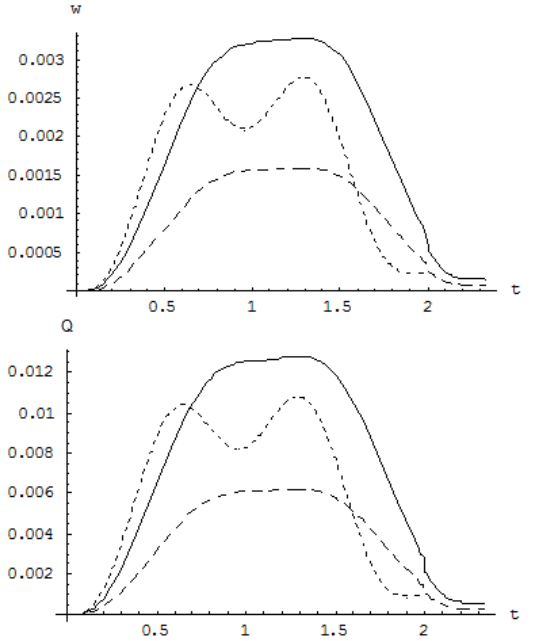
Figure 24: The vertical-torsional motion of the middle of the bridge (at x = L /2 ), for R = 50 m, υ = 30 m/s, e H = 3.00 m, e V = 1.20 m and three models of loading ( __ ) the real vehicle, (- - -) sequence of two loads, ( .... ) one concentrated load.